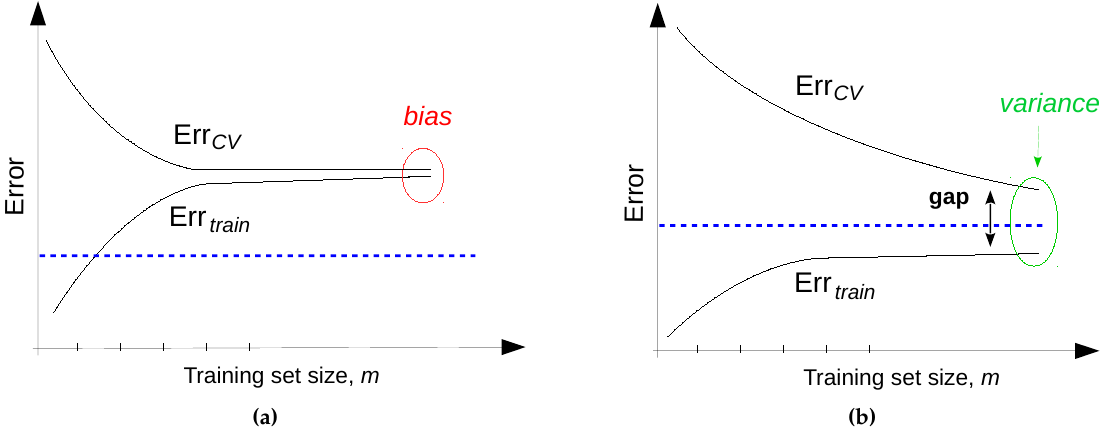
Figure 12. Diagnosing the bias-variance problem ( a ) Learning curves indicating high bias; ( b ) Learning curves indicating high